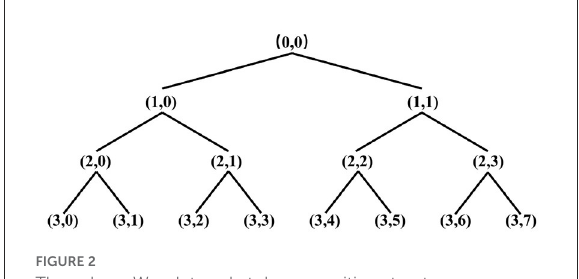
FIGURE2 Three-layer Wavelet packet decomposition